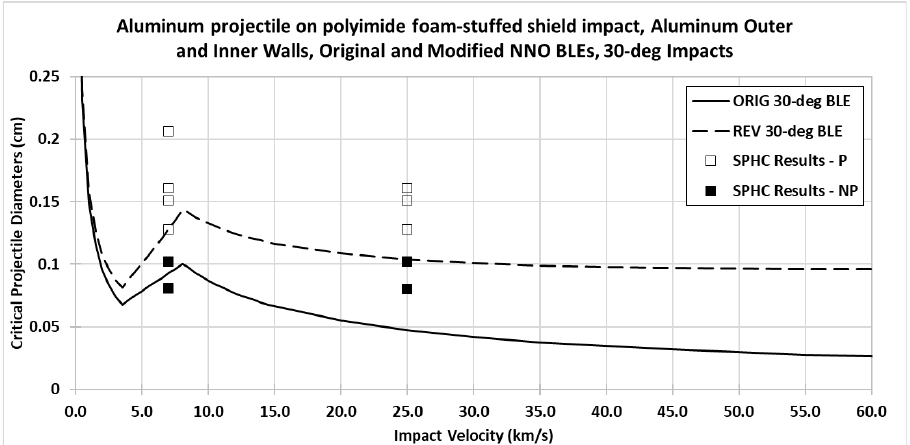
Figure 5. Comparison of Original and Modified NNO BLEs against P/NP data in [12] for Dual-Wall Systems with Aluminum Outer and Inner Walls.